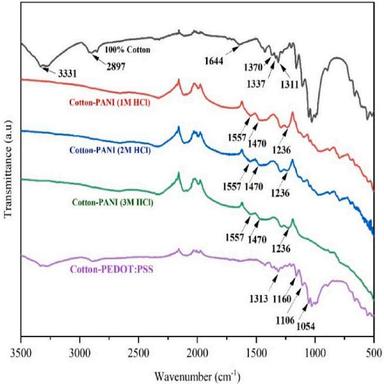
FTIR spectrum of PANI and PEDOT: PSS incorporated Cotton fabric in different states.